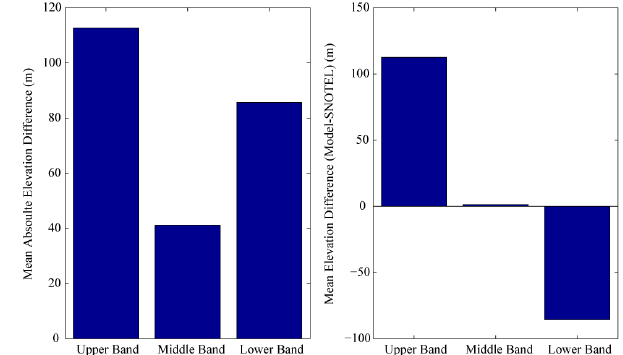
Fig. 2. Scatter-plot comparing the elevation that each model band represents and the elevation of its respective SNOTEL observation site.